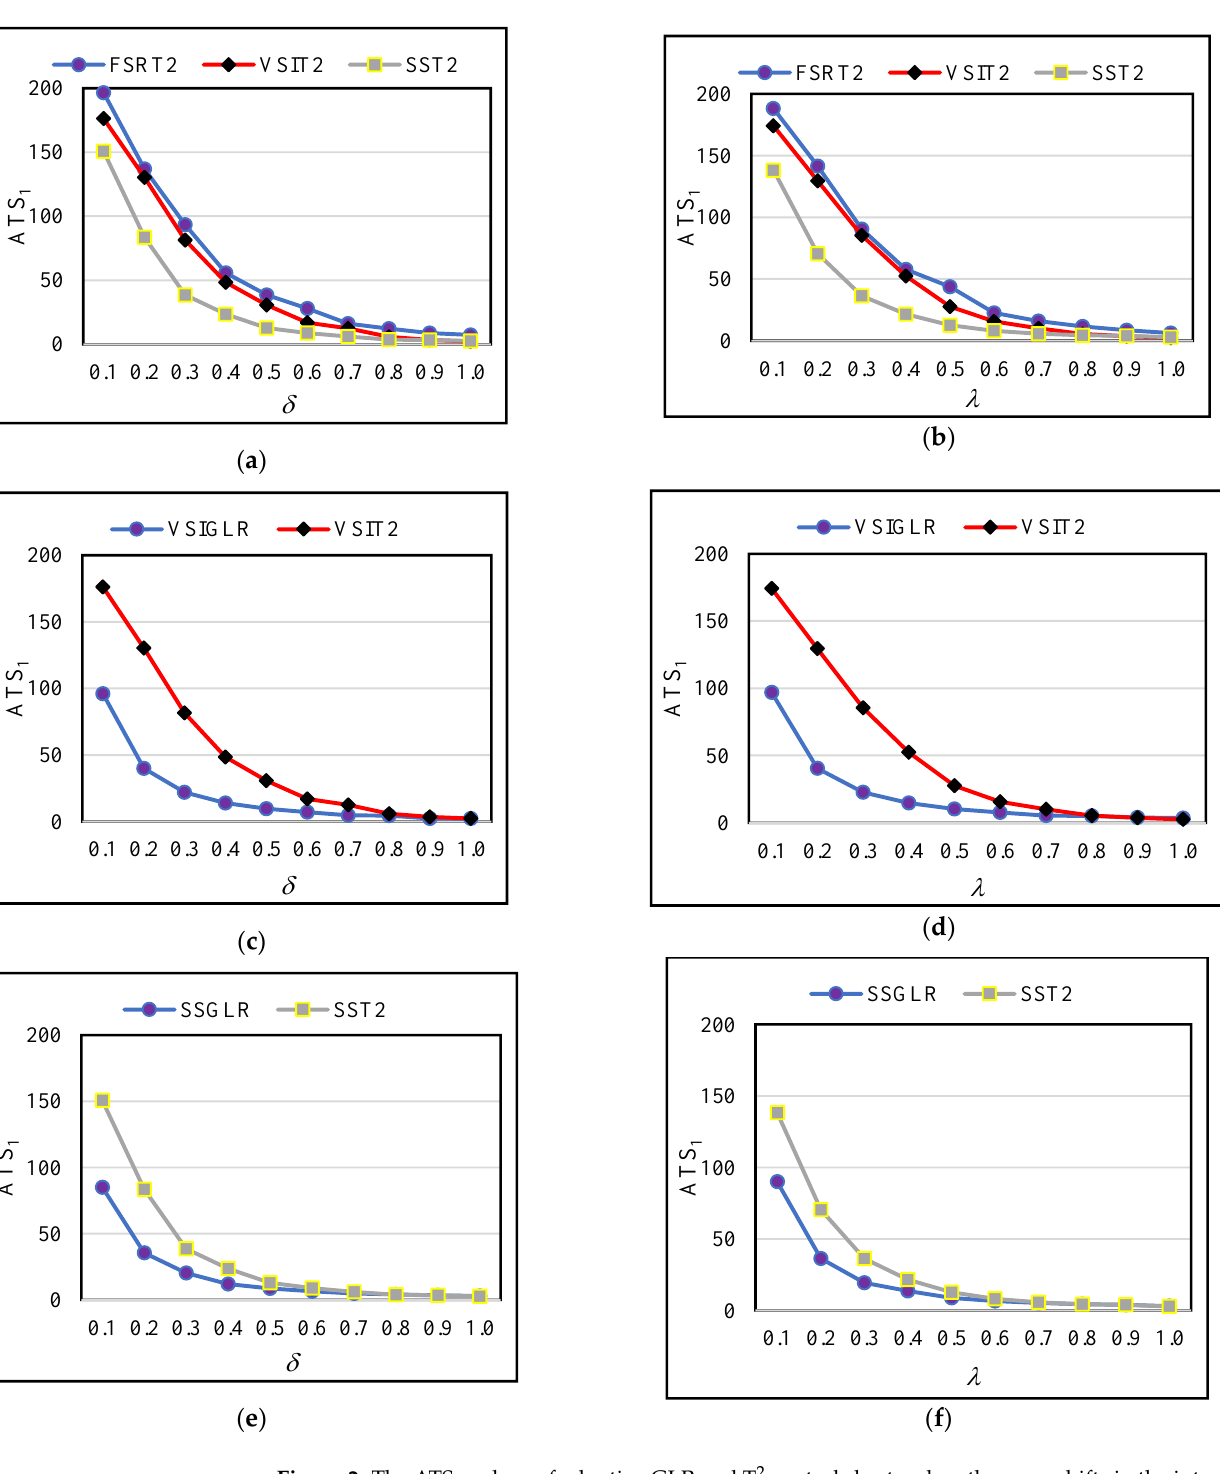
Figure 2. The ATS 1 values of adaptive GLR and T 2 control charts when there are shifts in the intercept (left panels ( a , c , e )) and slope (right panels ( b , d , f )). Figure 2a,b compared the performance of the T 2 control chart under FSR, VSI,